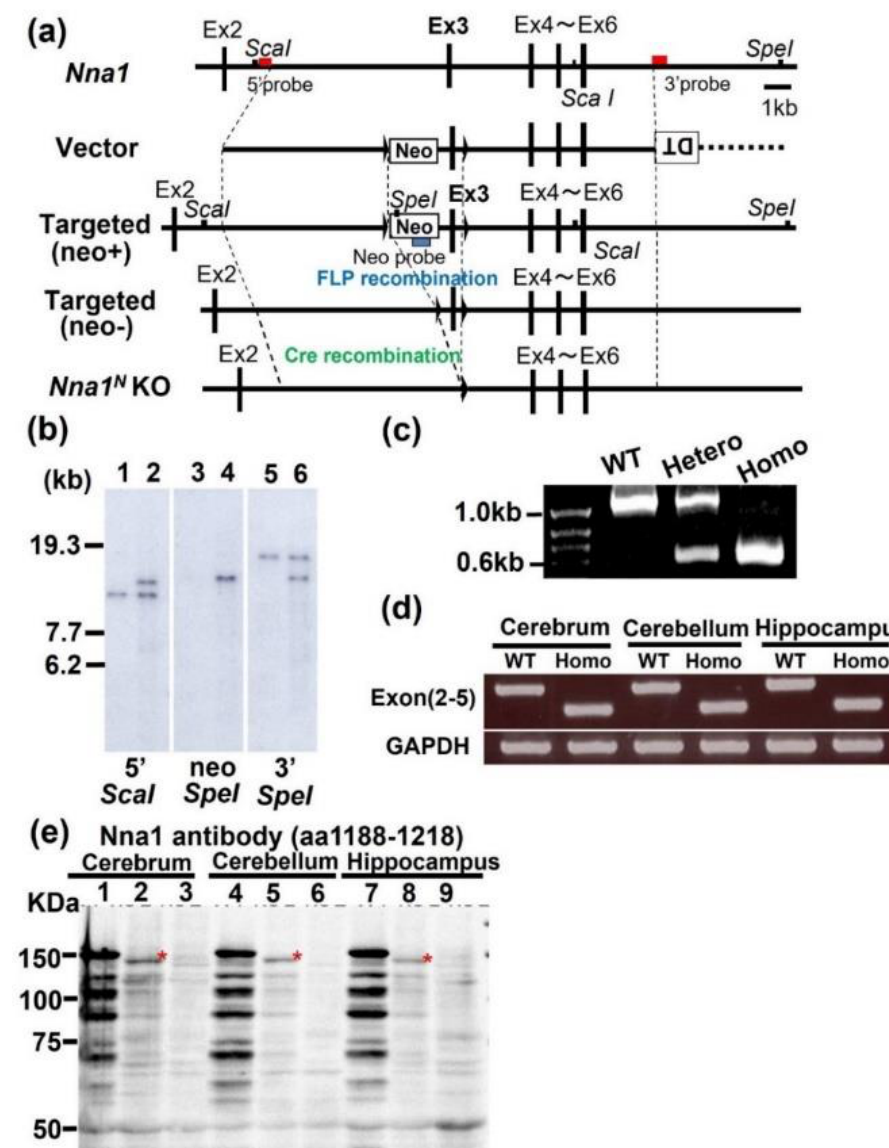
Figure 1. Generation of Nna1 N KO mice. ( a ) Schematic representation of genomic DNA, WT allele, targeting vector, targeted allele, and KO allele after Cre-mediated recombination. Dark boxes repre- sent exon sequences; white open boxes represent neo cassette (Neo) or diphtheria toxin cassette (DT). loxP sites are indicated by triangles. Red bars indicate 5 (cid:48) or 3 (cid:48) probe regions used for Southern blot analysis. 5 (cid:48) outer probe by ScaI, Neo probe and 3 (cid:48) outer probe by SpeI. ( b ) Southern blot analysis for genomic DNAs from wild-type (WT) and chimeric mice. WT: l, 3, 5, chimera: 2, 4, 6 (n = 3 mice in each genotype). ( c ) Genotypes of WT or Nna1 N KO mice were identified by PCR. ( d ) RT-PCR for detecting exon 3 deletion (n = 3 mice in each genotype). ( e ) Western blot analysis with anti-Nna1 antibody (Frontier Institute). Lanes 1, 4, and 7 indicate WT mice, Lanes 2, 5, and 8 indicate Nna1 N KO mice, and Lanes 3, 6, and 9 indicate Nna1 C KO mice. In the Nna1 N KO brain, lower bands compared to full-length Nna1 protein were detected in Nna1 N KO mice (asterisks) and faint bands in ladder-like patterns (n = 3 mice in each